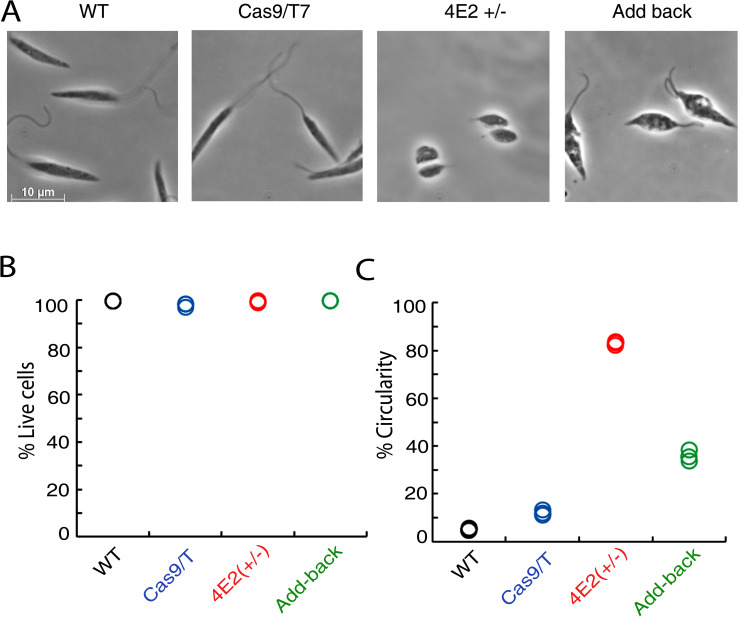
The LeishIF4E2(+/-) mutant shows altered promastigote morphology.(A) Mid-log phase (Day 2) promastigotes of WT, Cas9/T7 expressers, LeishIF4E2(+/-) cells, and LeishIF4E2 add-back cells were fixed with 2% paraformaldehyde and visualized by phase contrast microscopy at 100x magnification. WT, Cas9/T7 expressing cells showed normal promastigote morphology while LeishIF4E2(+/-) were round with reduced flagellar length. (B) All the cell lines were stained with 20 μg/mL propidium iodide (PI) for 30 min and cell viability was analyzed using the ImageStream X Mark II Imaging flow cytometer (Millipore). 20,000 cells were analyzed for each sample and percent viable cells were determined. (C). The circularity of single, viable and focused cells from each of the cell lines was quantified using flow cytometry, and is shown as percentage of the total number of cells measured. Data from three independent experiments are shown.